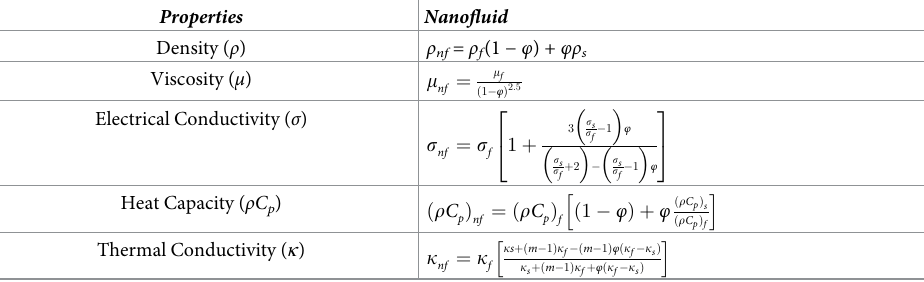
Table 1. Correlations between physical properties of base fluid and nanoparticles.